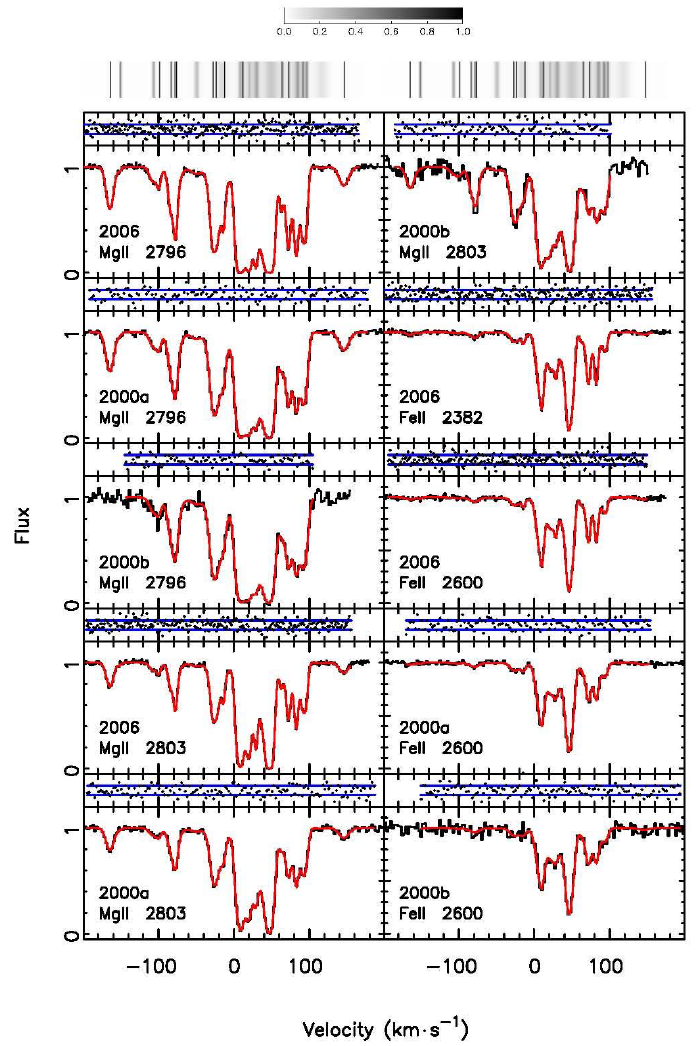
Figure 1. Comparison of the Bayesian Model Averaging (BMA) model and the data for the most complex synthetic spectrum (37 velocity components) in our sample. Above the figure is a grayscale plot showing the relative likelihood of velocity components at each pixel (the scale is shown at the top). Each row in the figure shows two panels: the top panel compares the residuals (black points) to the 1 σ expected fluctuations (horizontal blue lines). The bottom panel compares the BMA model (smooth red line) to the data (black). The BMA model is determined by summing over all models weighing by the relative likelihood of each model. In this figure, we show the first 10 data regions contributing to the ∆ α / α analysis. Figure 2 shows the remaining 8 data